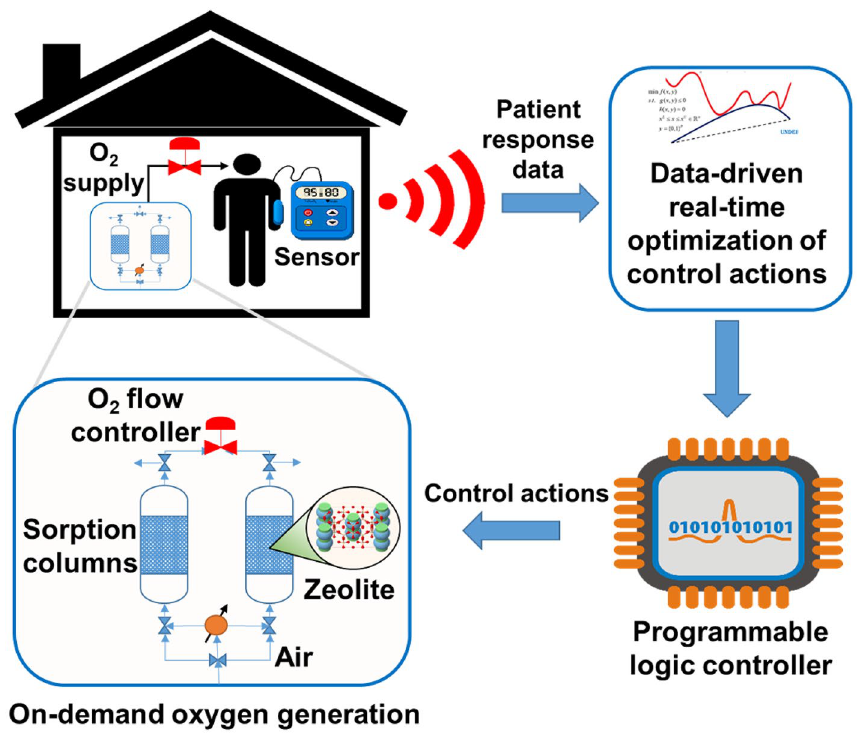
Figure 1. Envisioned cyber-physical system for online oxygen demand sensing and home-based delivery using adsorption-based medical oxygen concentrator